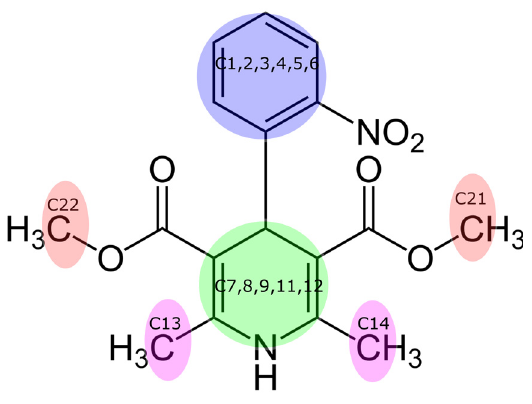
Figure 6. Examples of the complexes formed by two GA 2 − ions and a nifedipine molecule in water ( a – c ). Nifedipine molecule is depicted by its van der Waals radii. Water molecules and Na ions are not shown.